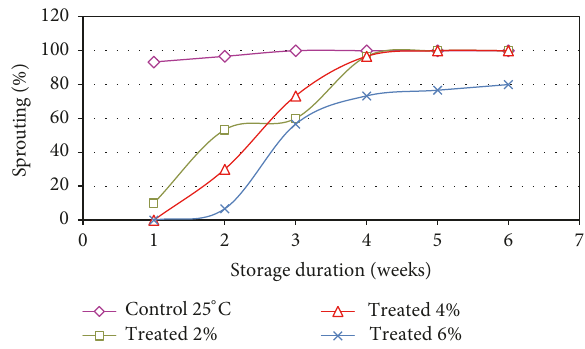
Figure 1: Effect of RCEO on potato sprouts length during storage: evolution of percentage of sprouting during storage at different